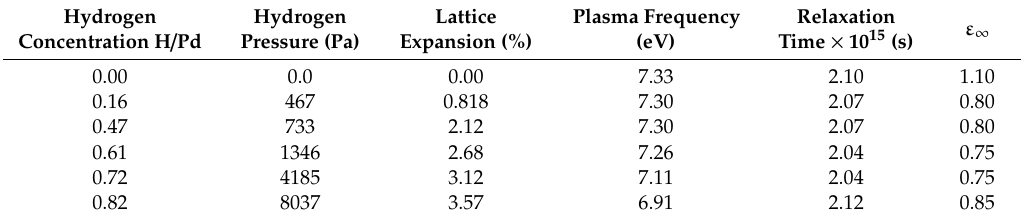
Table 1. Optical properties and lattice expansion of palladium (Pd) with respect to hydrogen concentration